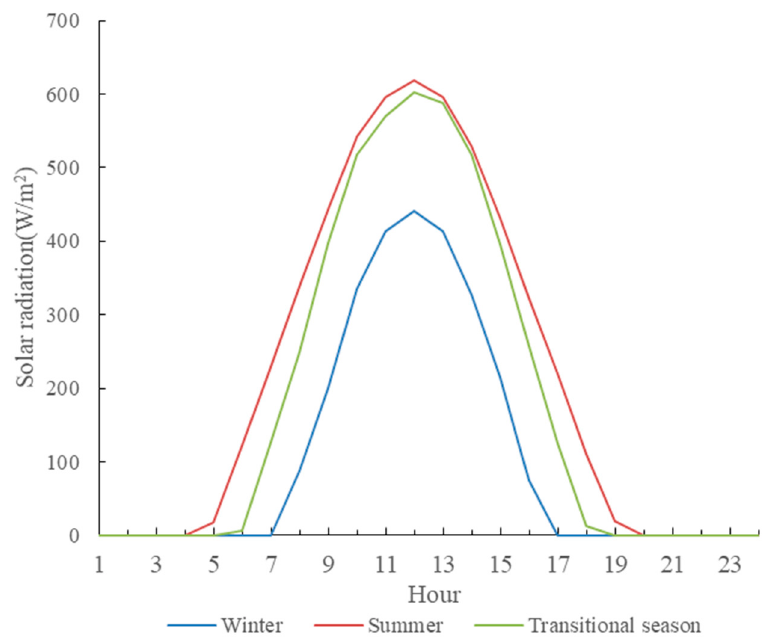
Figure 4. Solar radiation in different seasons.